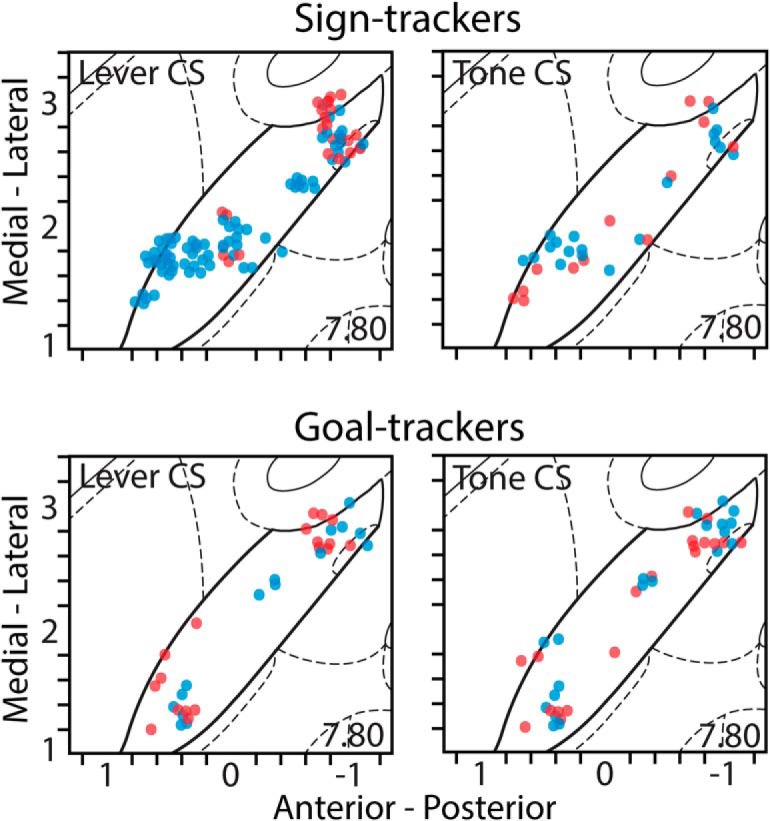
The approximate anatomic location of cells recorded in the VP that showed a sustained response during the 8-s period of cue exposure. Each dot represents a single responsive cell and indicates whether it showed an excitatory response (red) or an inhibitory response (blue). Top row, during lever-CS trials, STs showed a concentration of excitatory responses in the posterior portion of the VP and a concentration of inhibitory responses in the anterior portion of the VP, both of which are visibly diminished in the tone-CS trials. Bottom row, in GTs, both excitatory and inhibitory responses to the CS are sparsely distributed compared to the STs, with little difference between the lever-CS and tone-CS trials.